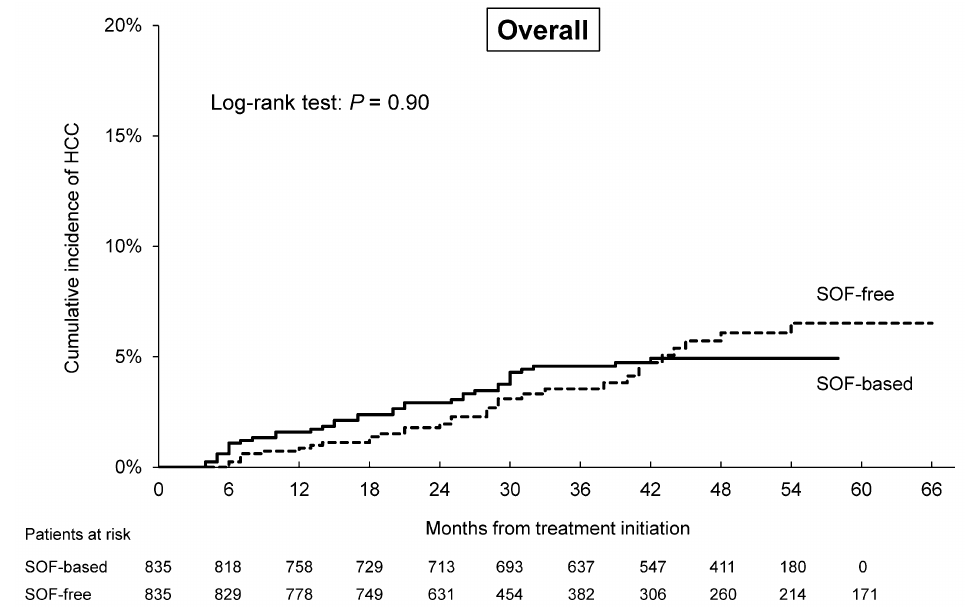
Figure 2. Cumulative rates of the development of hepatocellular carcinoma (HCC) in patients treated with DAA regimens with and without sofosbuvir (SOF). SOF-based: continuous line, SOF-free: dashed line.